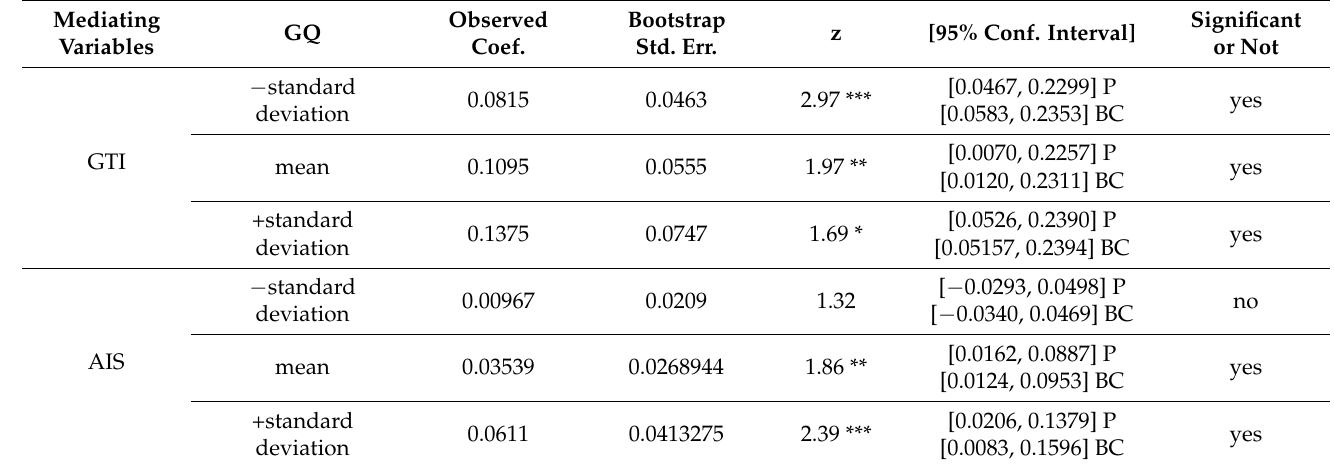
Table 6. Bootstrap test for the mediating effect of moderation.